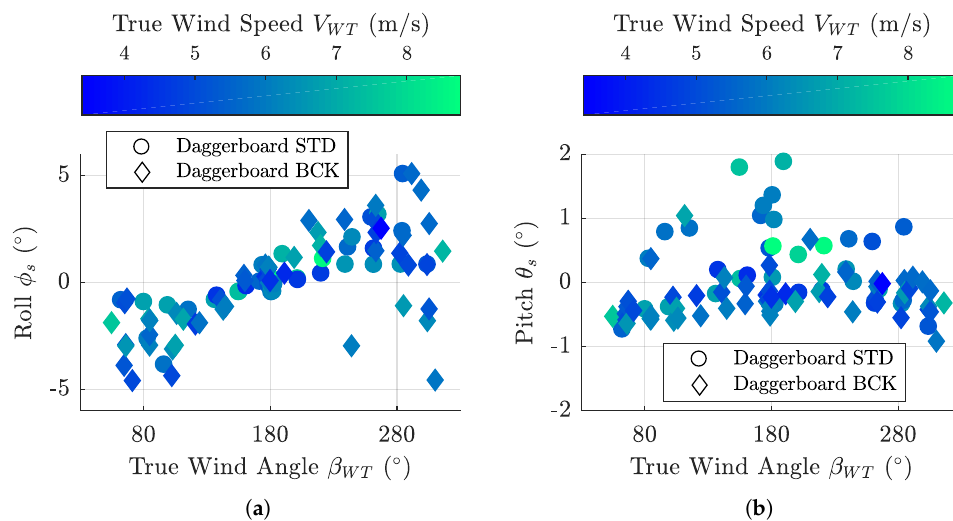
Figure 16. Effects of the daggerboard choice on roll ( a ) and pitch ( b ) angles of the kiteboat, according to the true wind